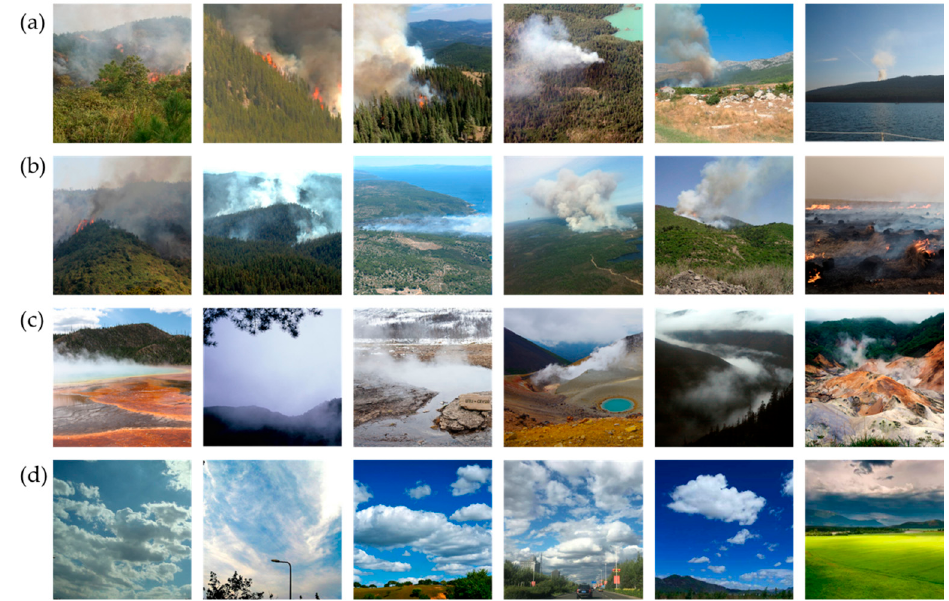
Figure 5. Sample images from the training and testing sets. ( a ) Smoke image, ( b ) smoke image, ( c ) fog image, and ( d ) cloud image.